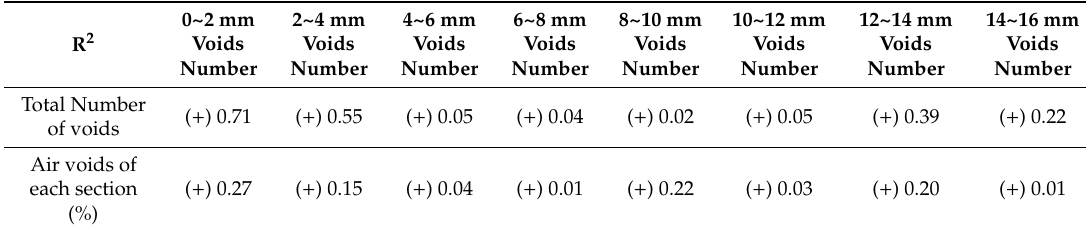
Table 2. Coe ffi cient Determinant Table 2. Coefficient Determinant Matrix.